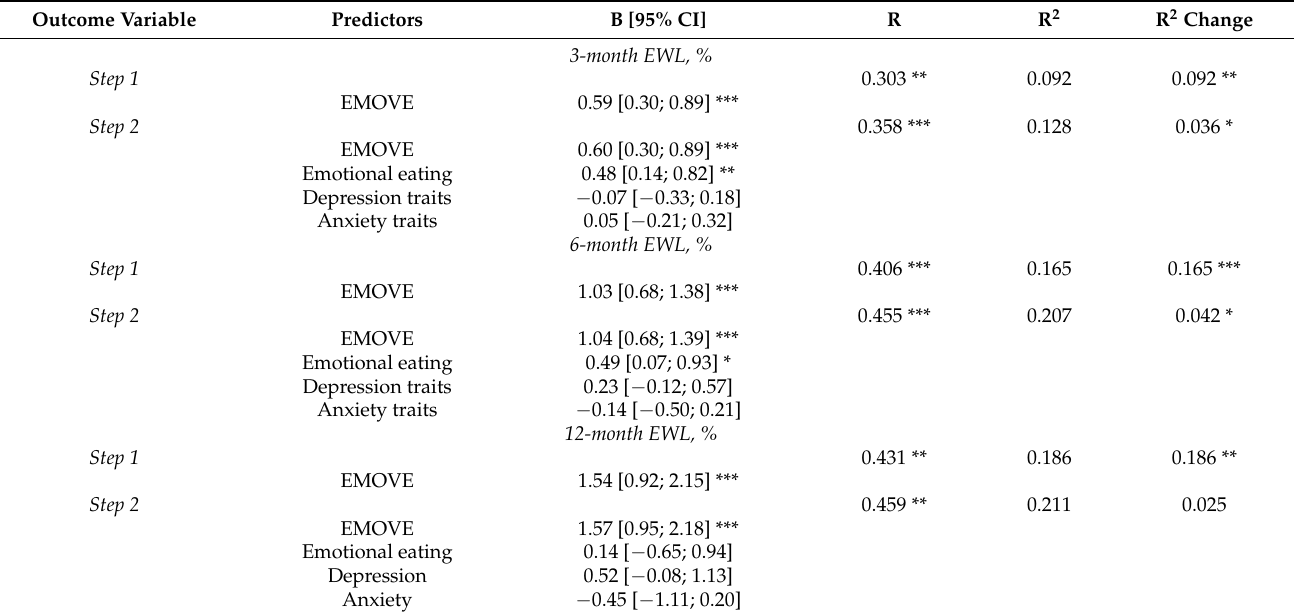
Table 3. Hierarchical multivariate regression analyses of predictors of the percentage of excess weight loss (%EWL) 3, 6, and 12 months after the EBT.